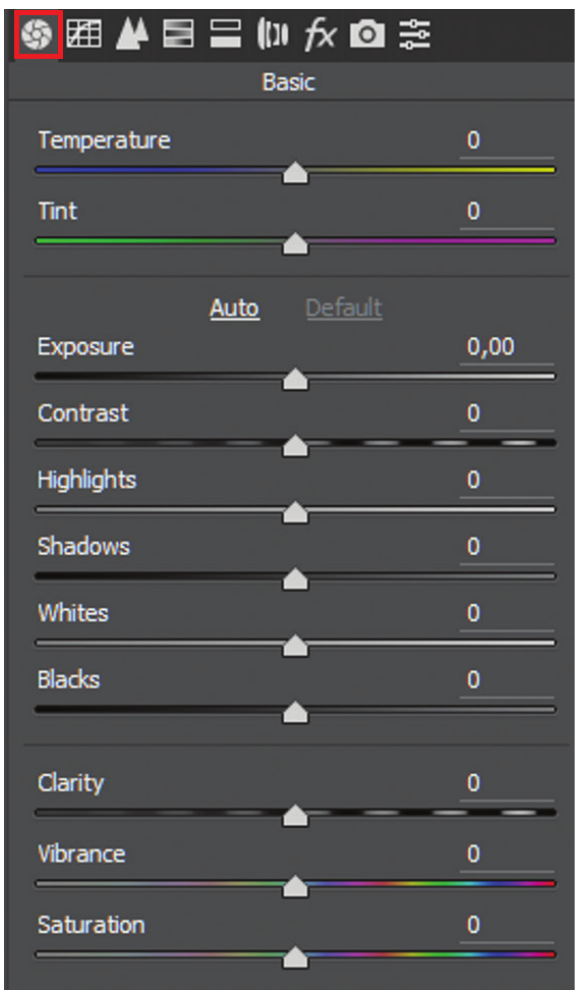
Figure 8. Basic Panel with possible white balance and lighting adjustments.